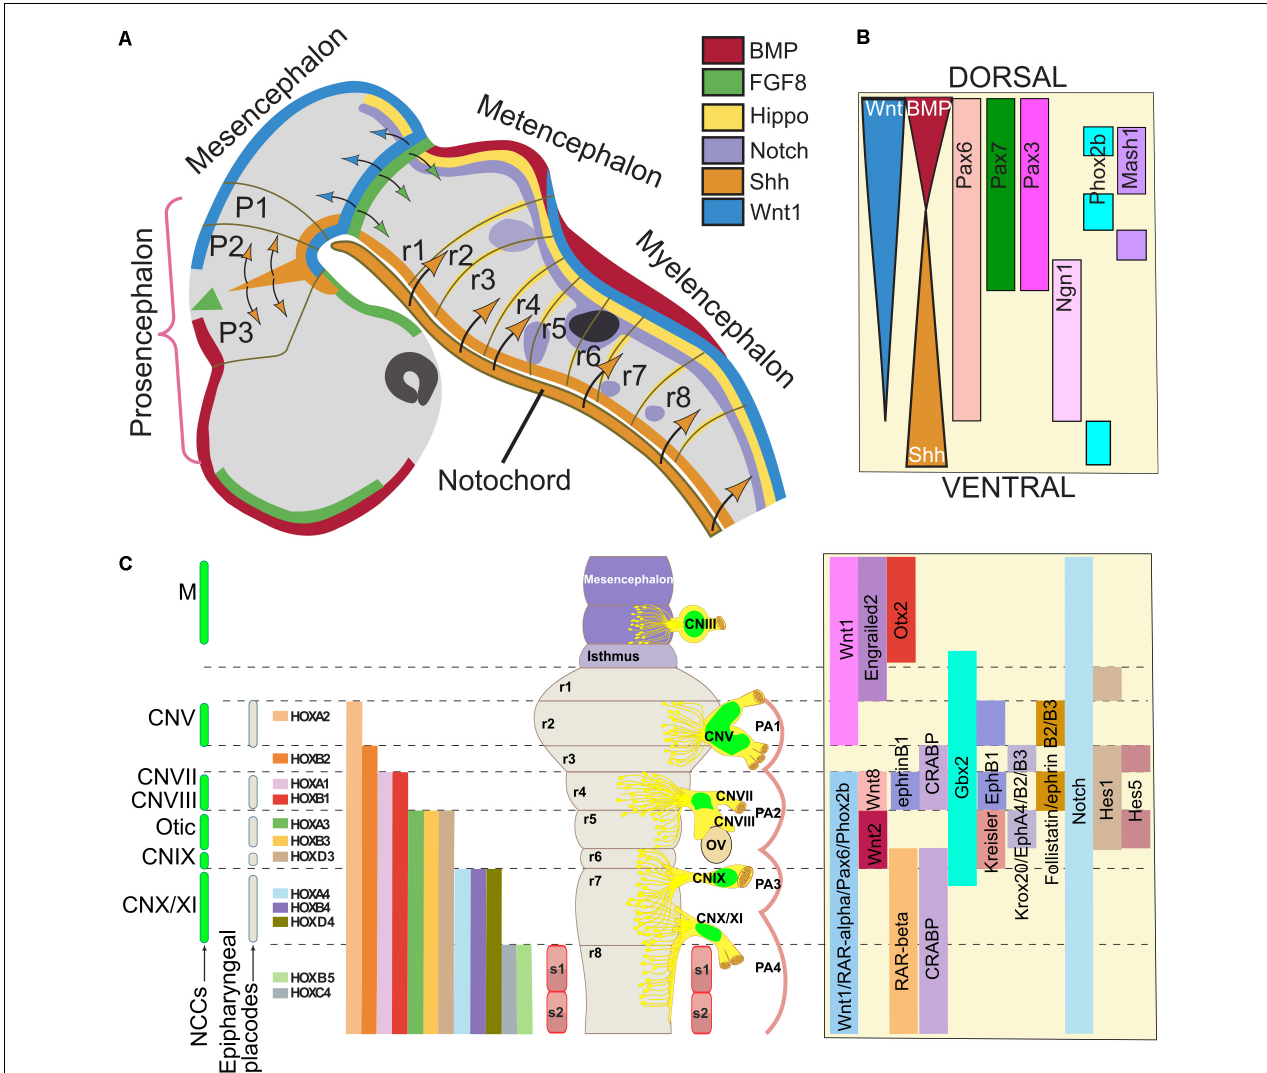
FIGURE 3 | Gene regulatory network involved in neural crest contribution to the formation of cranial nerves. The cranial ganglia and cranial nerves are formed in precise positions along the dorso-ventral and antero-posterior axes of the midbrain/hindbrain region. (A) The drawing represents a human embryo at stage 13 (30 days, 32 somites), equivalent to mouse day 9.5-10 (E9.5-10, 20 somites) and chick stage 14 (50 h, 22 somites). The cell signaling pathways that provide developmental cues to neural crest precursors are color-coded; when these factors diffuse, the target regions are indicated with arrows with the same color. In panel (B) , an idealized scheme of the hindbrain shows the cell signaling gradients and the genes that establish the dorsoventral pattern. (C) The illustration of the human (33 days, stage 14) and chick (stage 21) hindbrain rendered flat to eliminate cerebral flexures. The levels of origin of the neural crest cells (NCCs) and placodes, which contribute to the formation on cranial nerves, are indicated on the left. NCCs from the corresponding rhombomeres also populate other embryo structures in a segmental fashion and generate different craniofacial derivatives. The positions of the cranial ganglia and the otic vesicles are indicated on the right side; the contribution of NCCs is indicated in green. The segmental nested expression of HOX genes is color-coded. On the right, signaling pathways and the expression of transcription factors involved in cranial nerve (CN) formation are indicated. Adapted from Lumsden and Keynes (1989), Noden (1991), Yamamoto and Schwarting (1991), Bally-Cuif and Wassef (1995), Takahashi and Osumi (2002), and Müller and O’Rahilly (2011). Abbreviations: CN, cranial nerve; FP, floor plate; M, mesencephalon; NCCs, neural crest cells; OV, otic vesicle; r, rhombomere; PA, pharyngeal